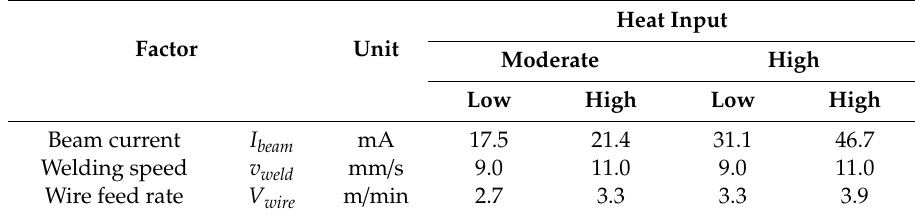
Table 3. Factor levels and combinations of full factorial design (FFD); moderate and higher values of deposition rates; and power